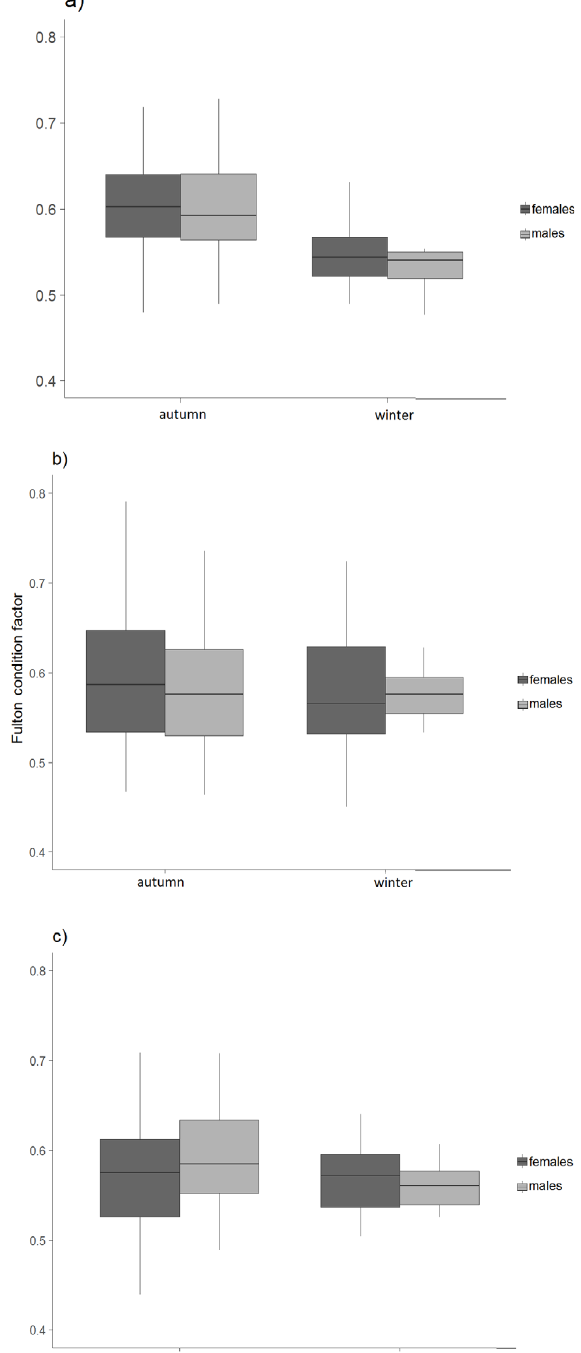
Fig. 6. The Fulton condition factor ( K ) for mature blue whiting, by sex (F – females; M – males) and by season (autumn and winter) along the areas of sampling: (a) north, (b) southwest and (c) south. The centre line of each box represents the median, the box limit indicates the 25th and 75th percentiles and the whisker delimits the non-outliers